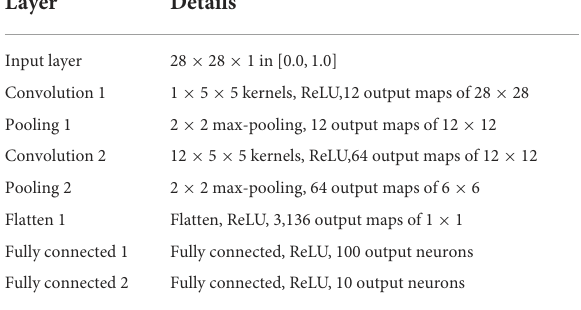
TABLE 5 CNN baseline model for MNIST dataset (with softmax output layer).